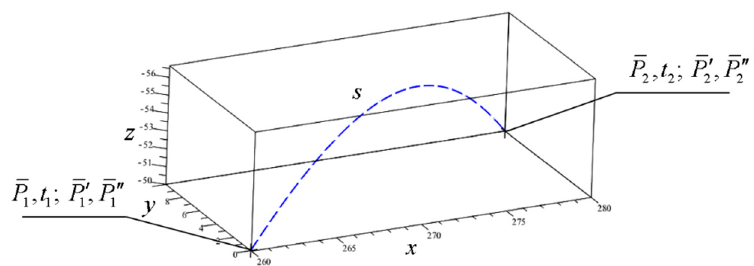
21 of 31 Table 5. Curvature and torsion values at boundary points of the segments. Segment Segment Boundary Knot Point